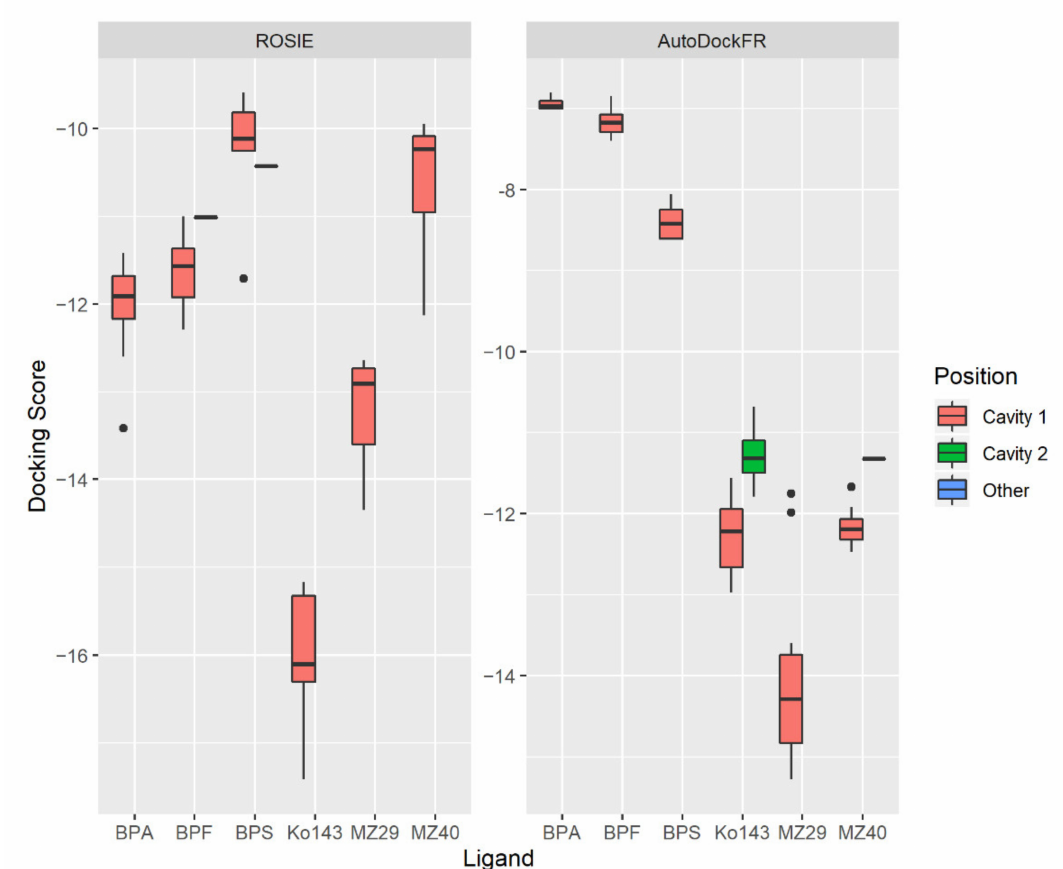
Figure 4. Docking score values for the binding of ligands to the BCRP, obtained by ROSIE and AutoDockFR. The lower the score, the better the predicted binding between the ligand and the BCRP. Ten docking scores were predicted for each compound, and the boxplots show median value and the interquartile range (IQR) plus whiskers up to the lowest/highest value < 1.5 × IQR. Dots show outlier values. ROSIE predicted one pose for BPF and BPS to be outside Cavity 1 and 2 (entitled “Other” in the graph). AutoDockFR predicted one pose in Cavity 2 for MZ40. As there was only one occurrence for each of these poses, these docking scores are shown as horizontal black